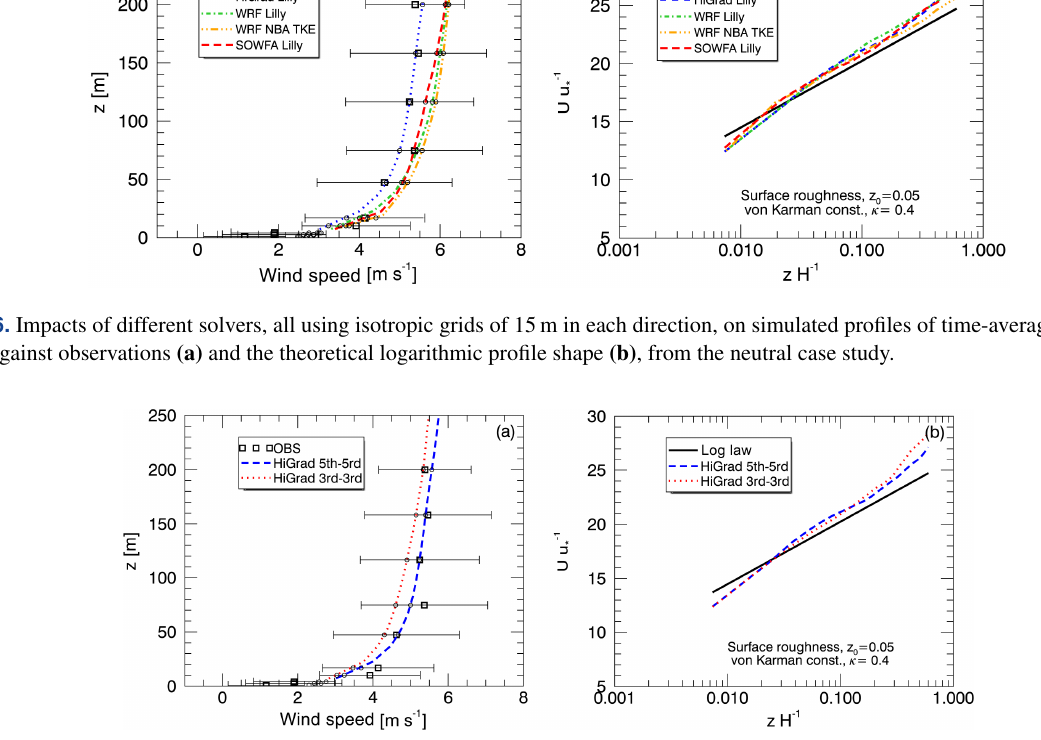
Figure 7. Impacts of different advection schemes within the HiGrad model, on simulated profiles of time-averaged wind speed plotted against observations (a) and the theoretical logarithmic profile shape (b) , from the neutral case study.